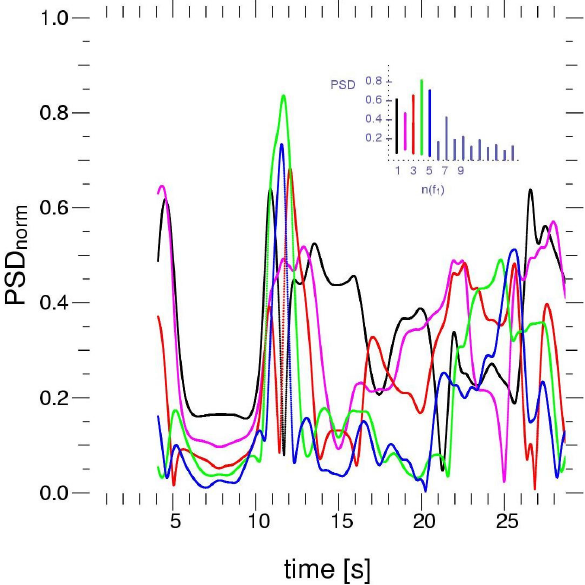
Fig. 4a. B z component profiles recorded at the points in the wave duct, plotted in white in Fig. 3. Except for the top profile, recorded at a point near noon, the following records and the corresponding zero-level lines, have been shifted by − 0.4 × N nT, for legibility ( N =0,...,9).